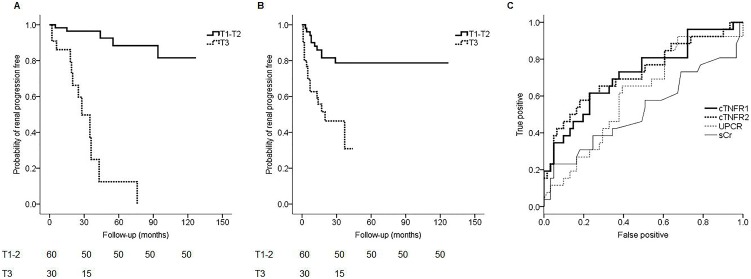
Kaplan-Meier survival curves of renal progression.(A) The patients with cTNFR1 level within the highest tertile had a significantly faster renal progression compared with those with cTNFR1 level within the other tertiles (P<0.001, log-rank test). (B) The patients with cTNFR2 level within the highest tertile also had a significantly faster renal progression compared with those with cTNFR2 level within the other tertiles (P<0.001, log-rank test). (C) ROC curves for circulating TNFR1 (cTNFR1), circulating TNFR2 (cTNFR2), UPCR, and serum creatinine (sCr) determining renal progression. The AUCs for cTNFR1, cTNFR2, sCr, and UPCR were 0.719 (95% confidence interval [95% CI]: 0.597–0.841), 0.724 (95% CI: 0.599–0.849), and 0.520 (95% CI: 0.375–0.666), 0.607 (95% CI: 0.479–0.735), respectively.